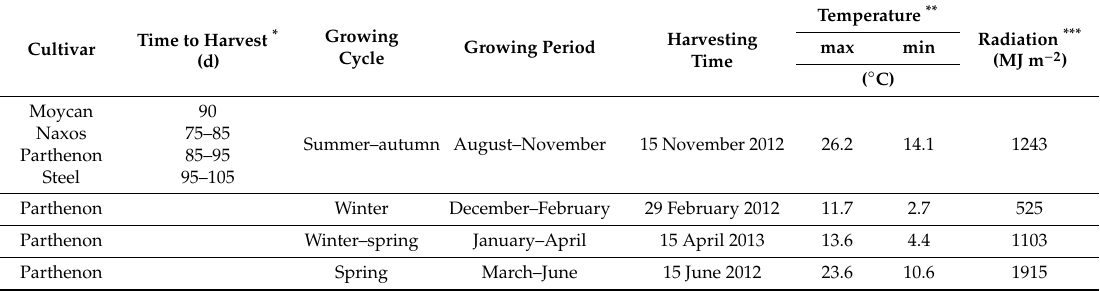
Table 1. Genotypes, growing cycles, harvesting times, and climate